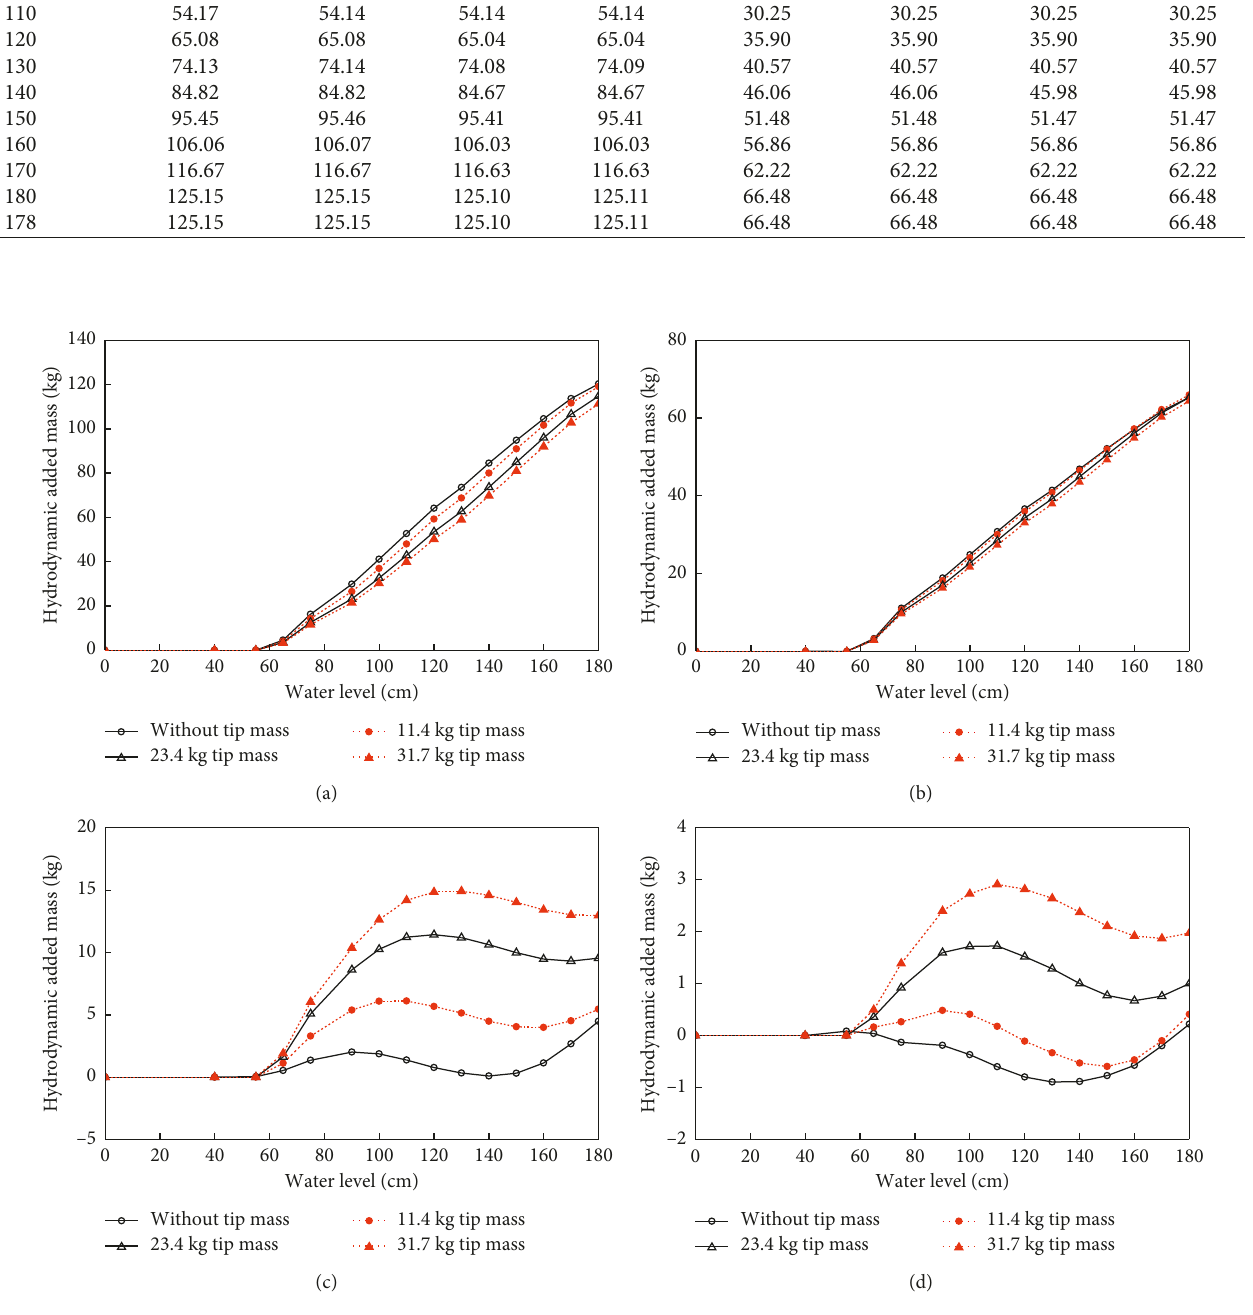
Figure 10: MHAM of the specimen for the four tip masses in case I as a function of water level, corresponding to (a) first mode along the x - axis; (b) first mode along the y -axis; (c) second mode along the x -axis; and (d) second mode along the y -axis.